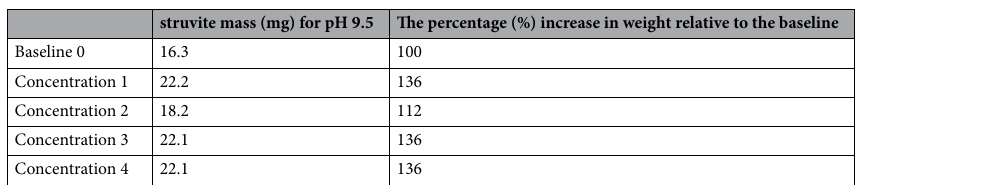
Table 3. Final (for pH 9.5) mass of struvite (mg) for all tested concentrations of P, for an exemplary one measurement series.